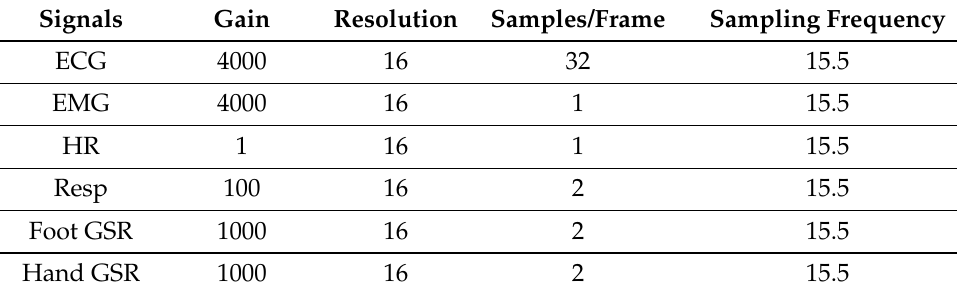
Table 1. Acquisition parameters for the physiological